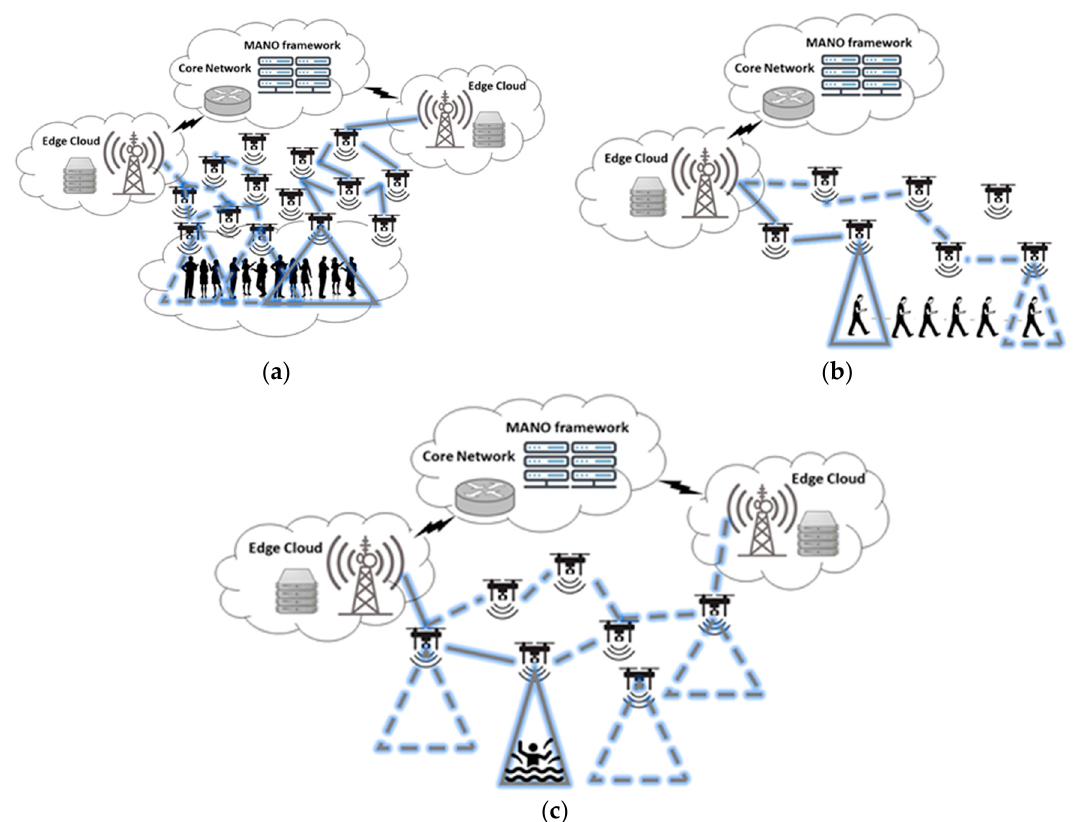
Figure 8. Fifth generation network demanding typical use case scenarios: ( a ) a crowded event; ( b ) moving users; ( c ) network recovery after natural disaster. moving users; ( c ) network recovery after natural